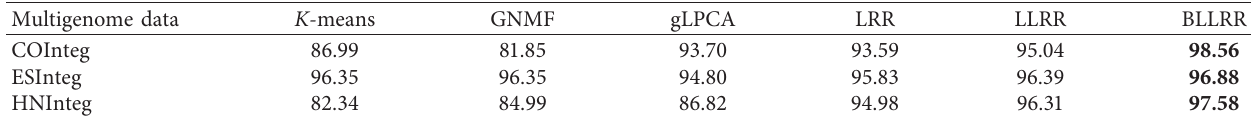
Table 3: The clustering accuracy on multigenome